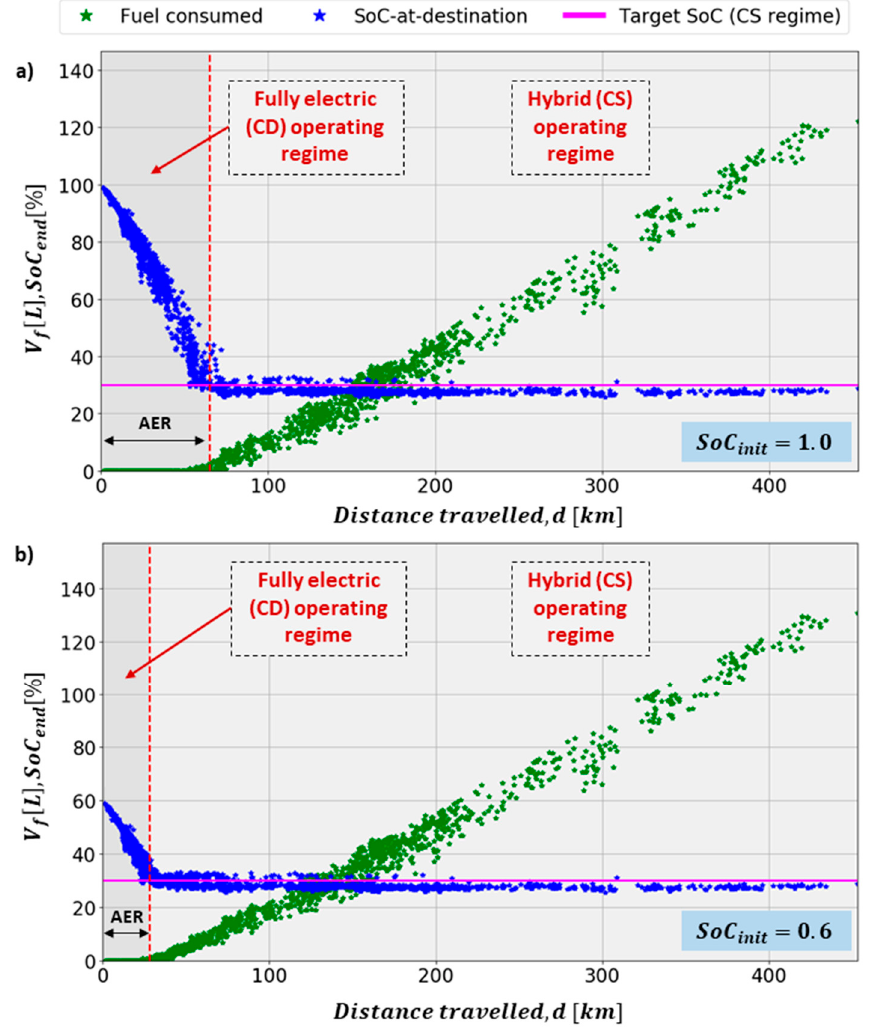
Figure 6. EREV fuel consumptions ( V f ) and SoC at destination ( SoC end ) in dependence of total distance travelled ( d ) for cases of initial SoC values SoC init = 1.0 ( a ), and SoC init = 0.6 ( b